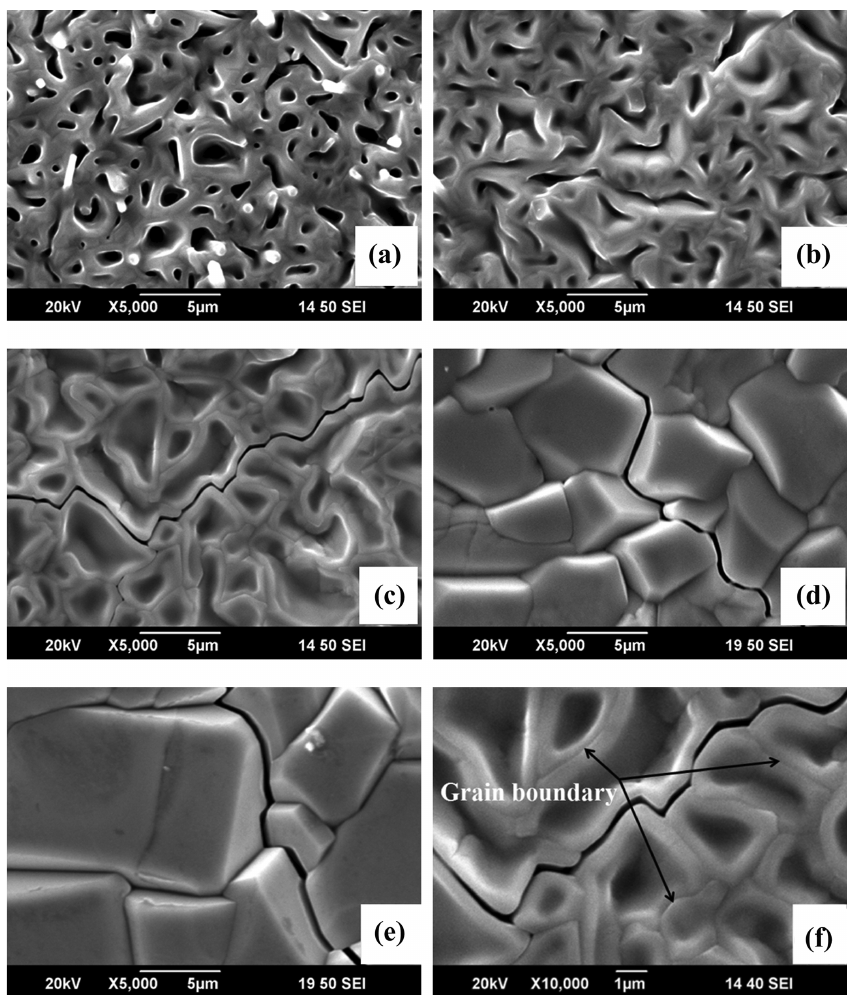
Figure 3: Surface scale morphologies of the oxide formed on Ferritic Steel T22 exposure to SCW at 620°C and 25 MPa. (a) 10 h (b) 80 h, (c) 200 h, (d) 600 h and (e) 1000 h, (f) High magnification image of